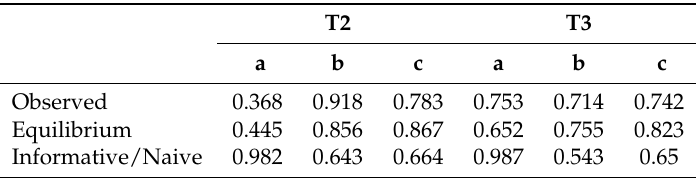
Table 7. Efficiency by state compared to